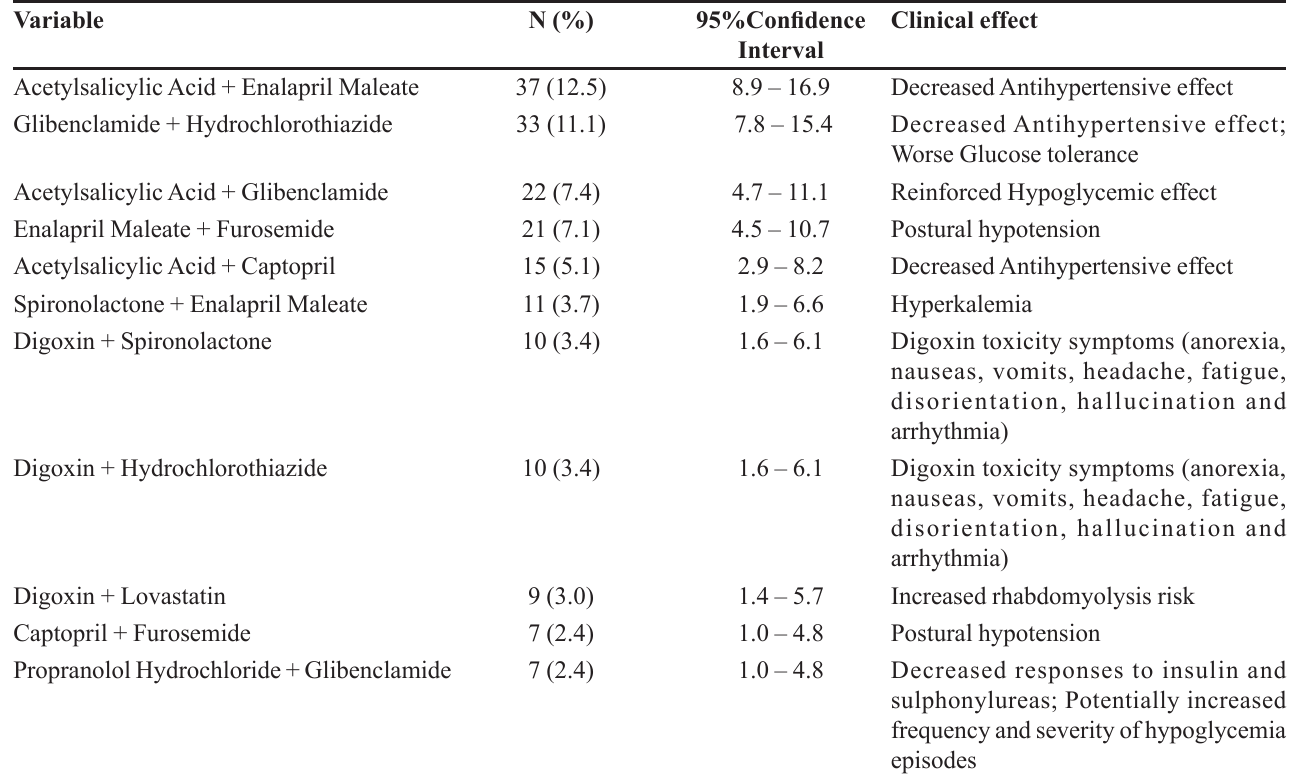
TABLE V - Most frequent potential drug-drug interactions and their clinical effects